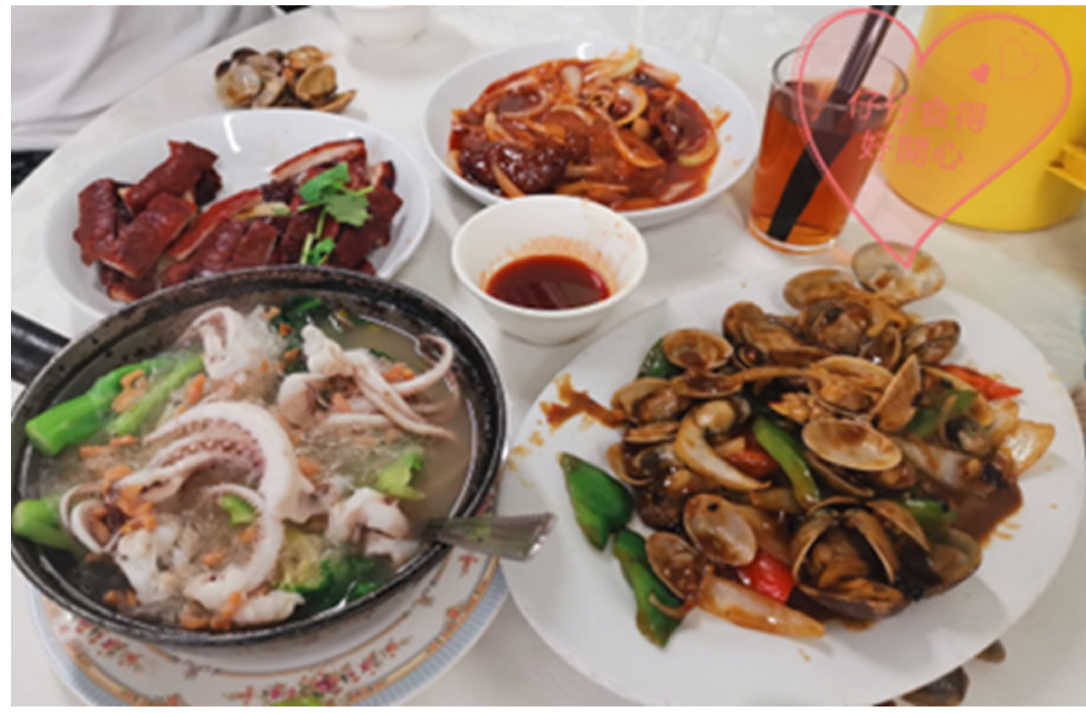
Figure 2. Photograph by Participant B.